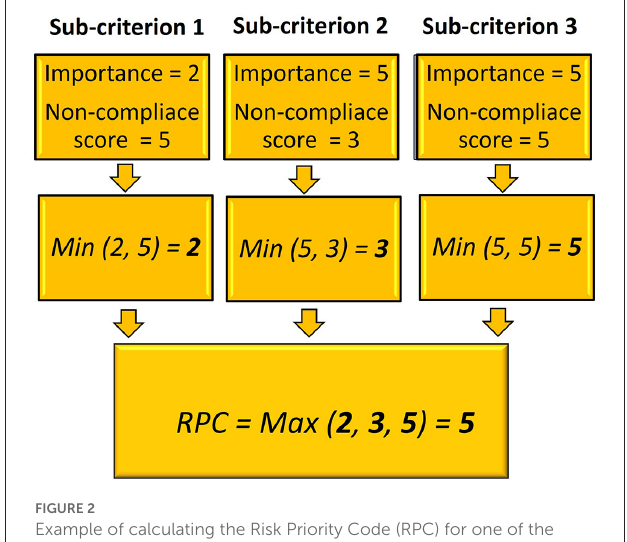
FIGURE2 Example of calculating the Risk Priority Code (RPC) for one of the main criteria, in a hypothetical pig farm, using the modified failure mode effect analysis. Sub-criterion 1 was assigned an importance score 2 by the 8 experts. While, in the assessment of biosecurity on = the farm by completing the checklist, the veterinarians assigned a high non-compliance score to this sub-criterion (score 5), indicating low = biosecurity. In the calculation, sub-criterion 1 contributed to the overall RPC with a value of 2, which is the minimum between 5 and 2. Sub-criterion 2, on the other hand, was assigned a high importance (5) and a moderate non-compliance score (3). Therefore, according to the procedure just described sub-criterion 2 was assigned a score of 3. Finally, sub-criterion 3 was assigned a high importance 5 and a = high non-compliance score (5). Therefore, sub-criterion 3 contributed 5 to the final result. In fact, the overall RPC for the main criterion, including sub-criteria 1 to 3, was equal to 5, which was obtained as the maximum of the three minimums: 2, 3 and